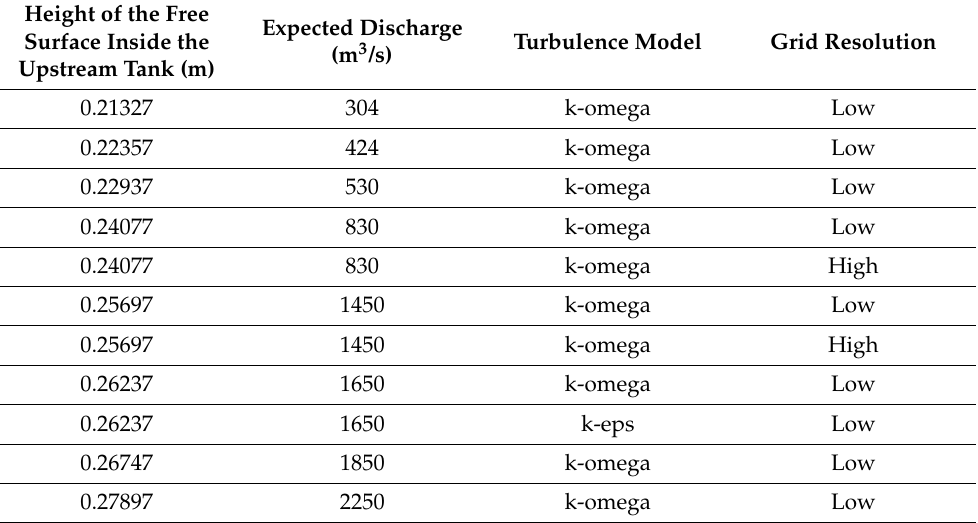
Table 4. Height of the free surface inside the upstream tank, expected flow rate and turbulence model adopted for Model